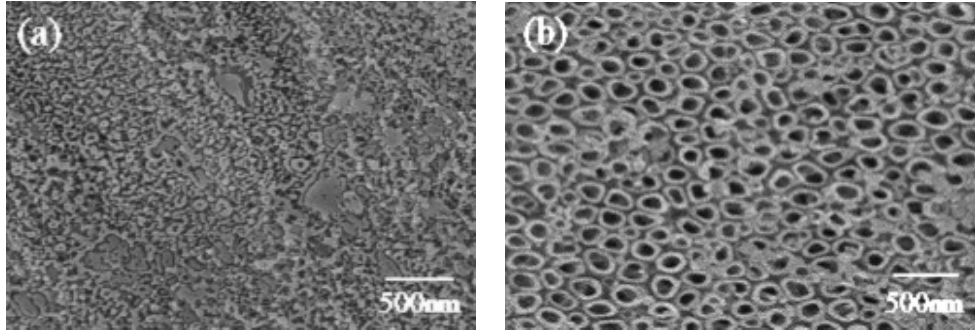
Figure 2. Field-emission gun scanning electron microscopy (FEG-SEM) images of the surface structures obtained by anodizing the Ti substrates, at different voltages before TiO 2 heat treatment: ( a ) 5 V; ( b ) 10 V; ( c ) 20 V; ( d ) 30